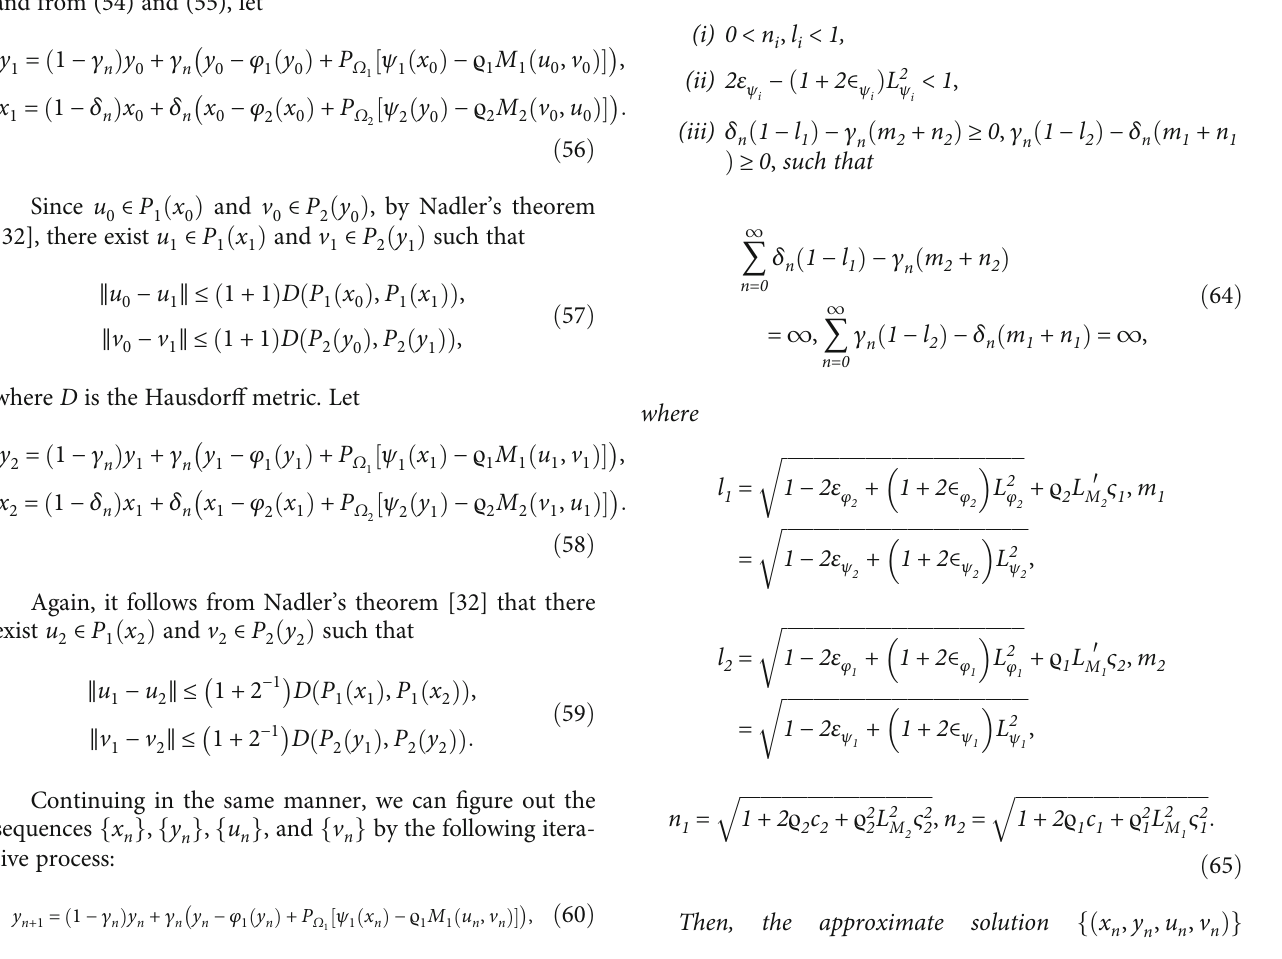
, δ ∈ ½ 0, 1 (cid:2) n n